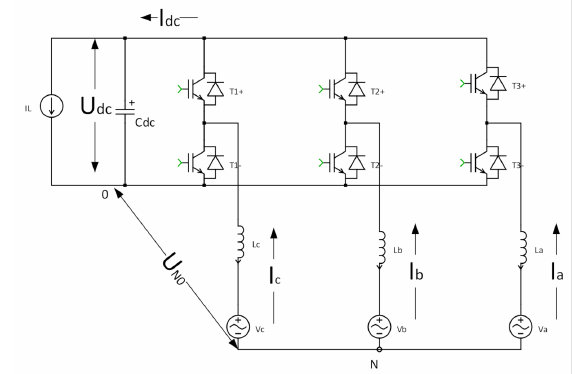
Figure 2. Block diagram of the bidirectional ac/dc